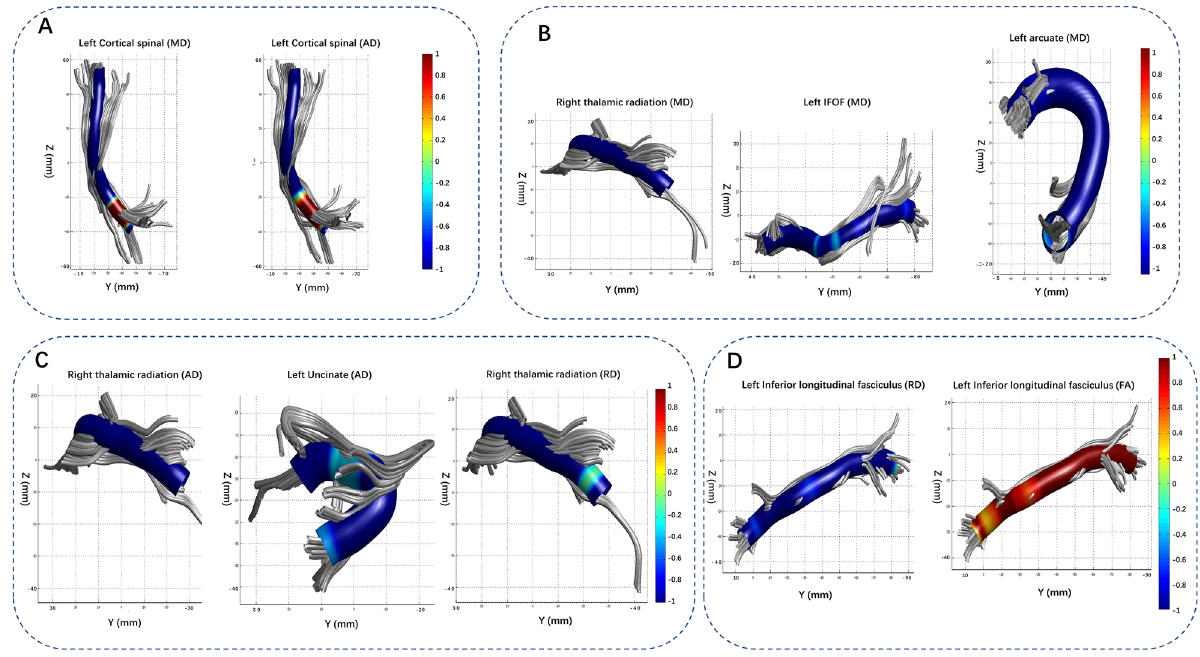
Figure 6. Three-dimensional figures of fiber segmentations with inter-group differences revealed by AFQ. Red-yellow parts indicate an elevation. A: The LIG group vs. control group comparison showed MD elevation in cortical-spinal tract. B-C: The RIG vs. control group comparison showed MD, AD, and RD elevation in the contralateral UF, ILF, and AC. D: Flipped HGG vs. LGG images revealed FA elevation in the contralateral